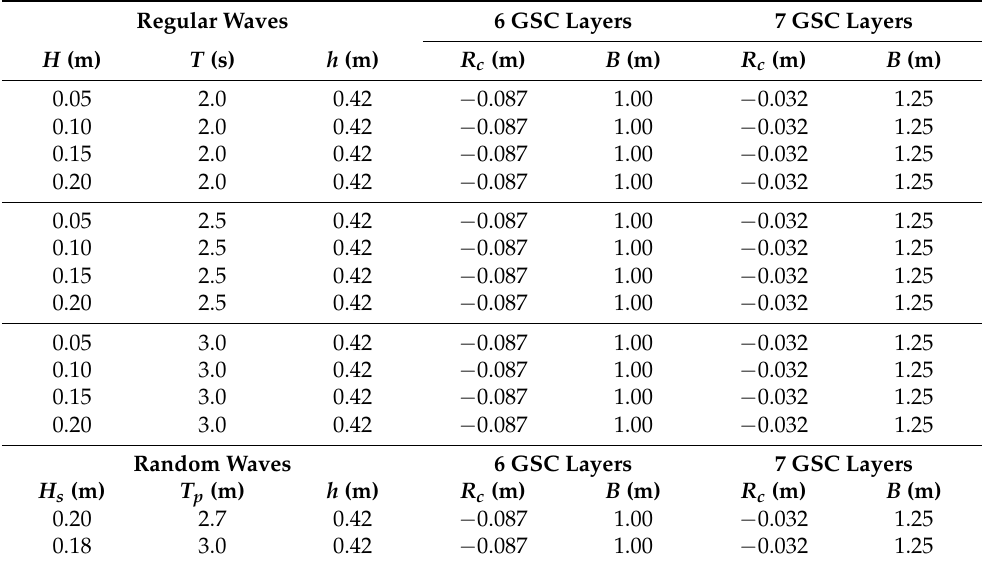
Table 3. Regular and random wave characteristics for submerged